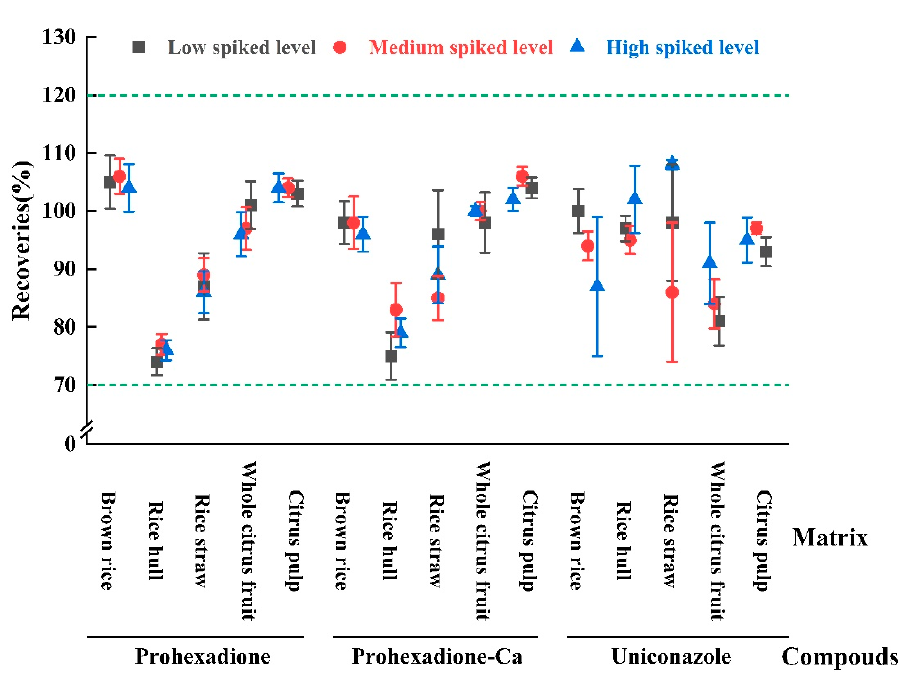
Figure 2. Recoveries of prohexadione, prohexadione-Ca and uniconazole in rice and citrus. When comparing the interference caused by the analyte’s solvent solution with the interference generated by the matrix effect (ME), the detector response can be affected. Therefore, it is necessary to consider matrix effects, with an ME value of >20% indicating signal reinforcement, ME < 0% representing signal inhibition, and ME values in the range of 0 to 20%, suggesting no matrix effect [42]. Therefore, to obtain more conclusive results, this study utilized standard matrix-matched calibration curves to identify residues in rice tests, while establishing standard solvent calibration curves in citrus tests for quantification using the external standard method. Figures S1 and S2 provided representative